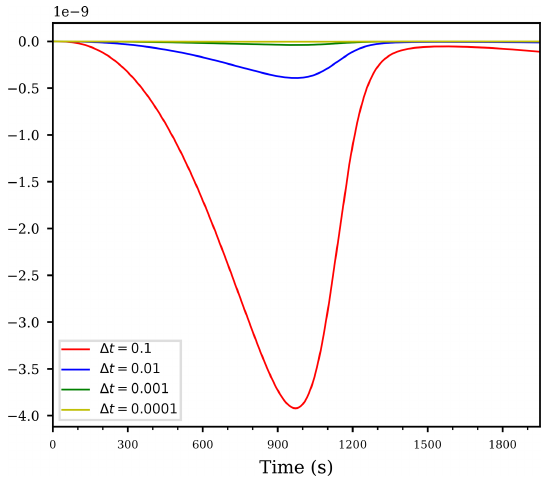
Figure 4. Temporal evolution of the derivative ∂q c steps (cid:49)t ∈ { 0 . 1 , 0 . 01 , 0 . 001 , 0 . 0001s } for the computation of the same case as in Fig.